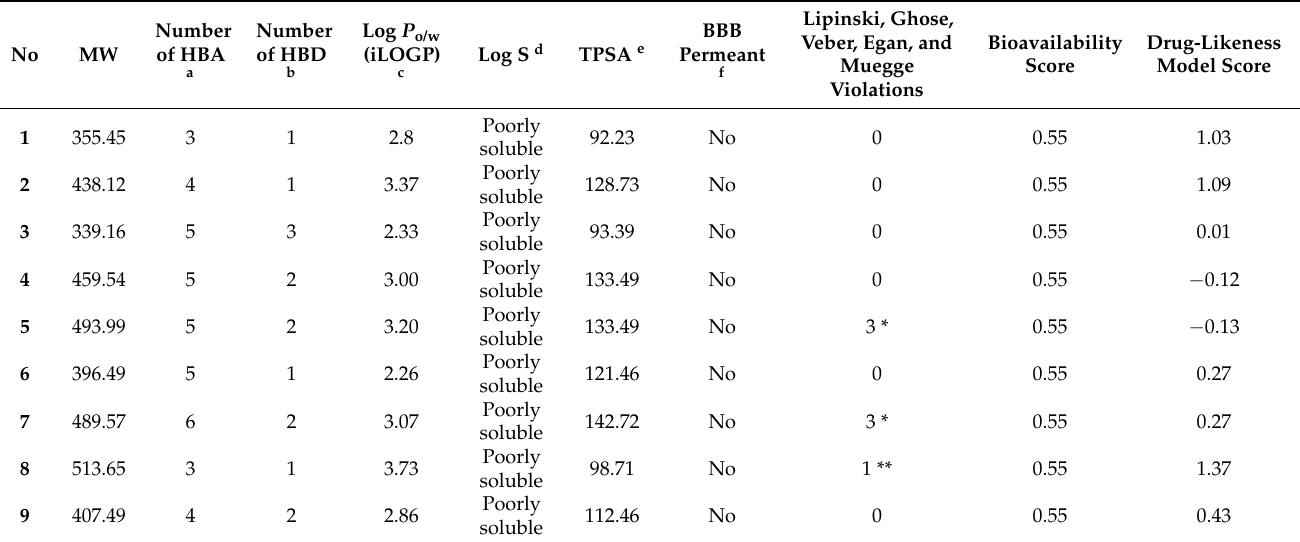
Table 6. Drug-likeness predictions of tested compounds.